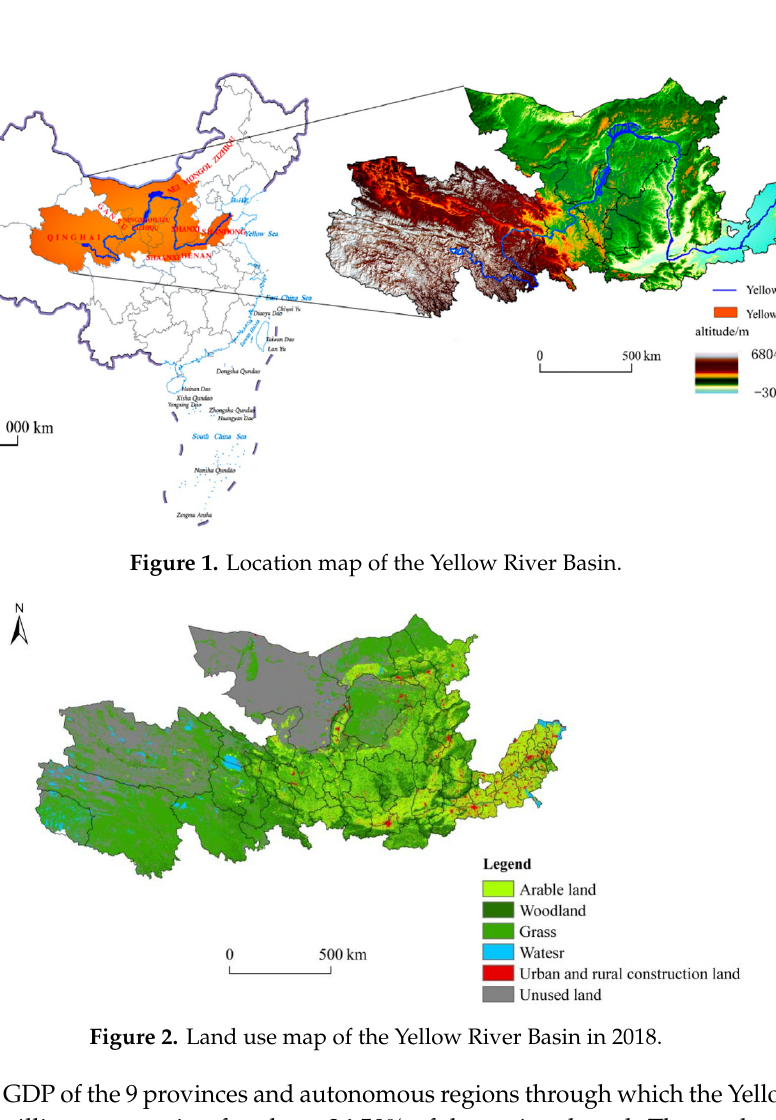
Figure 2. Land use map of the Yellow River Basin in 2018.